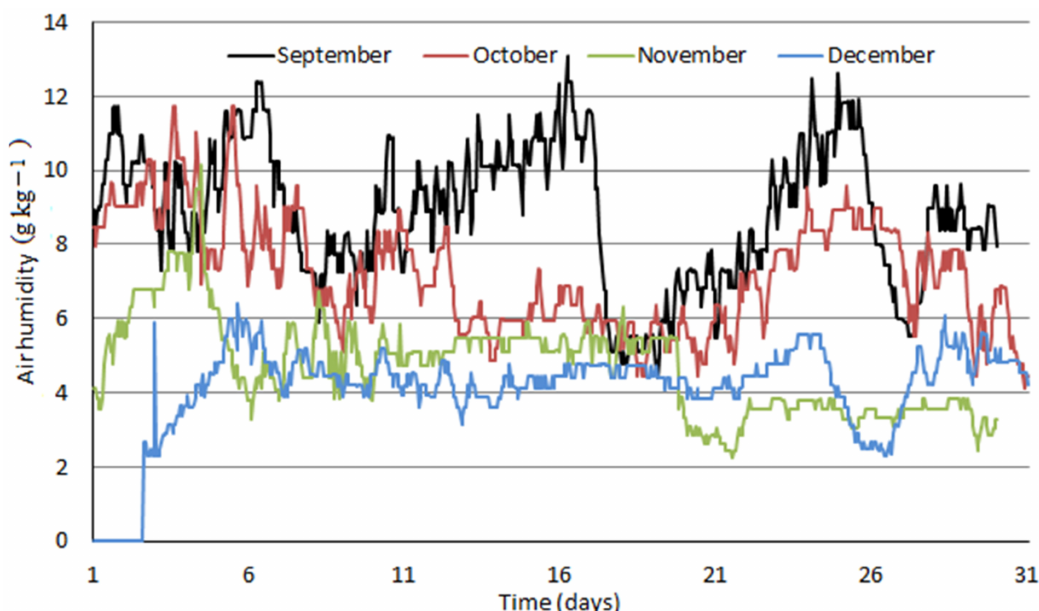
Figure 6. Hourly averages of air humidity in Košice—Center from September 2020 to December